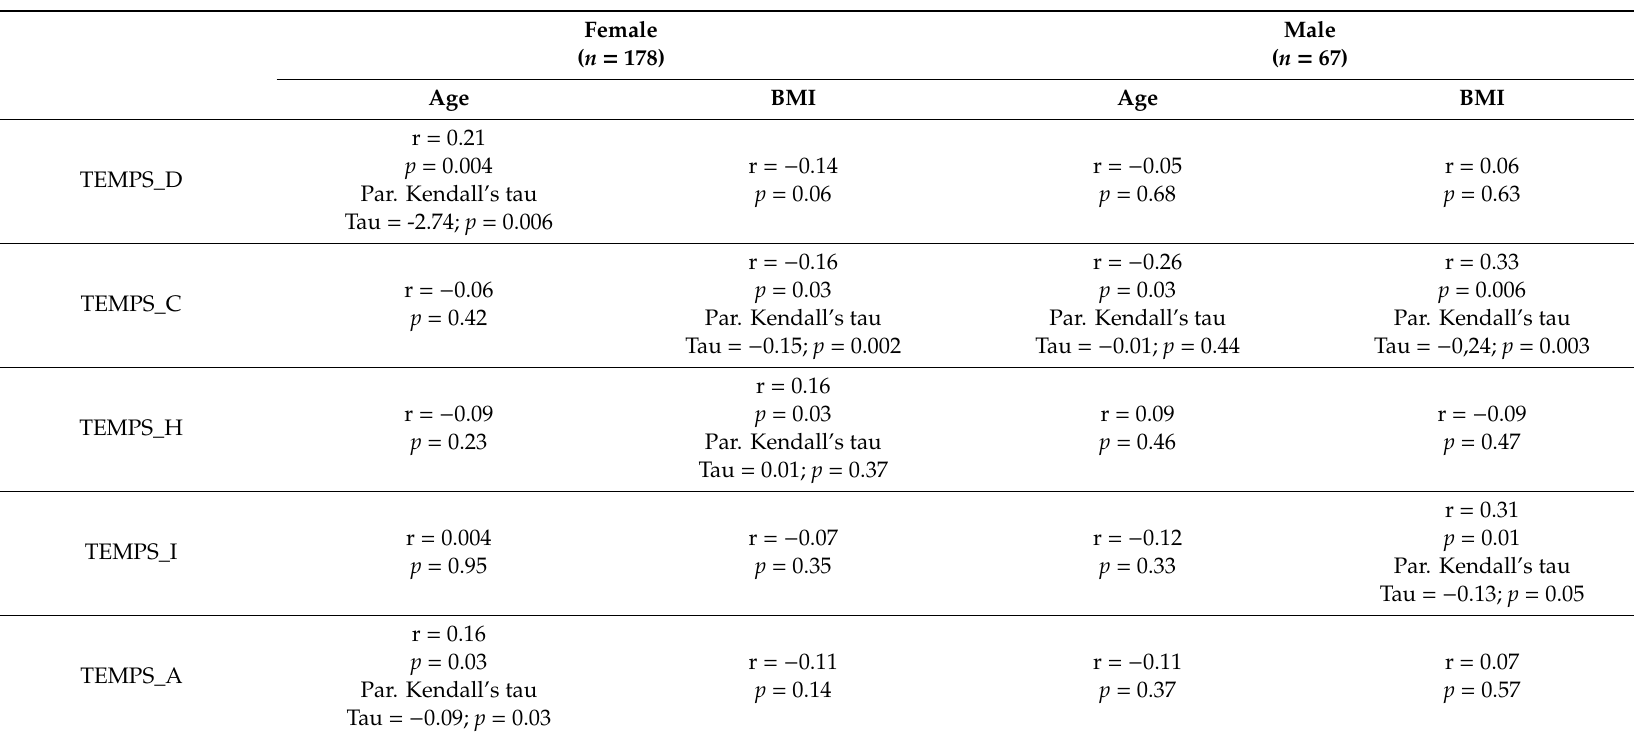
Table 2. R-Spearman correlations of the age and BMI result with the TEMPS scores in women and men. Partial Kendall regression for significant